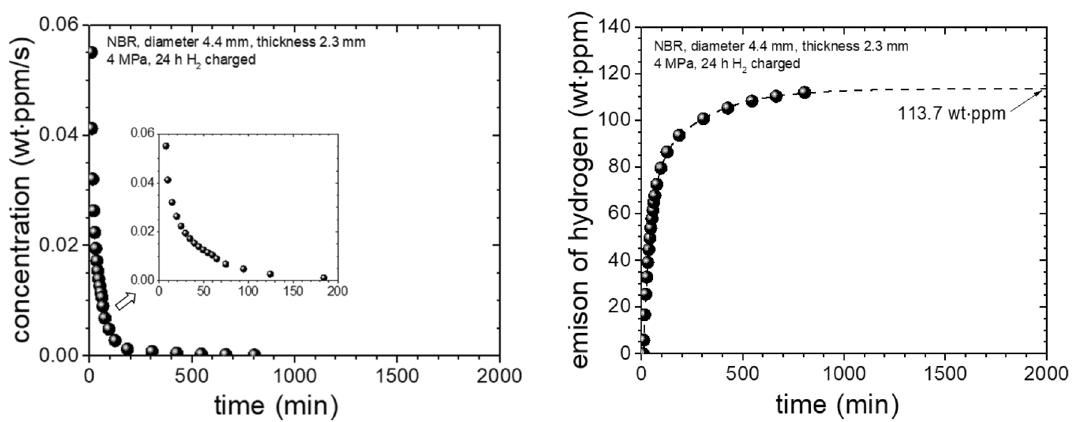
Figure 6. (Left) Time-dependent H 2 concentration curve of an NBR sample expressed in mass concentration per second. (Right) Integrated curve of the time-dependent H 2 concentration over time. The asymptotic value of 113.7 wt·ppm is obtained by extrapolating the integrated values using exponential